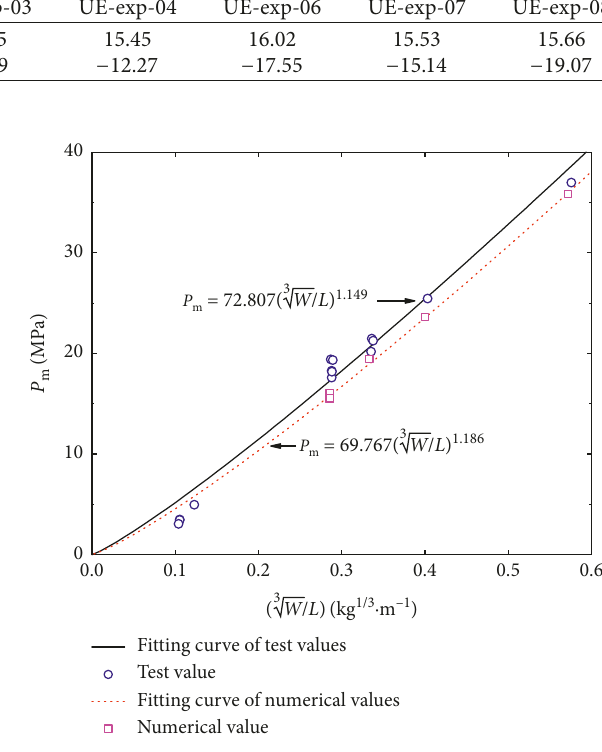
Figure 18: Relationship between shock wave peak pressures and proportional